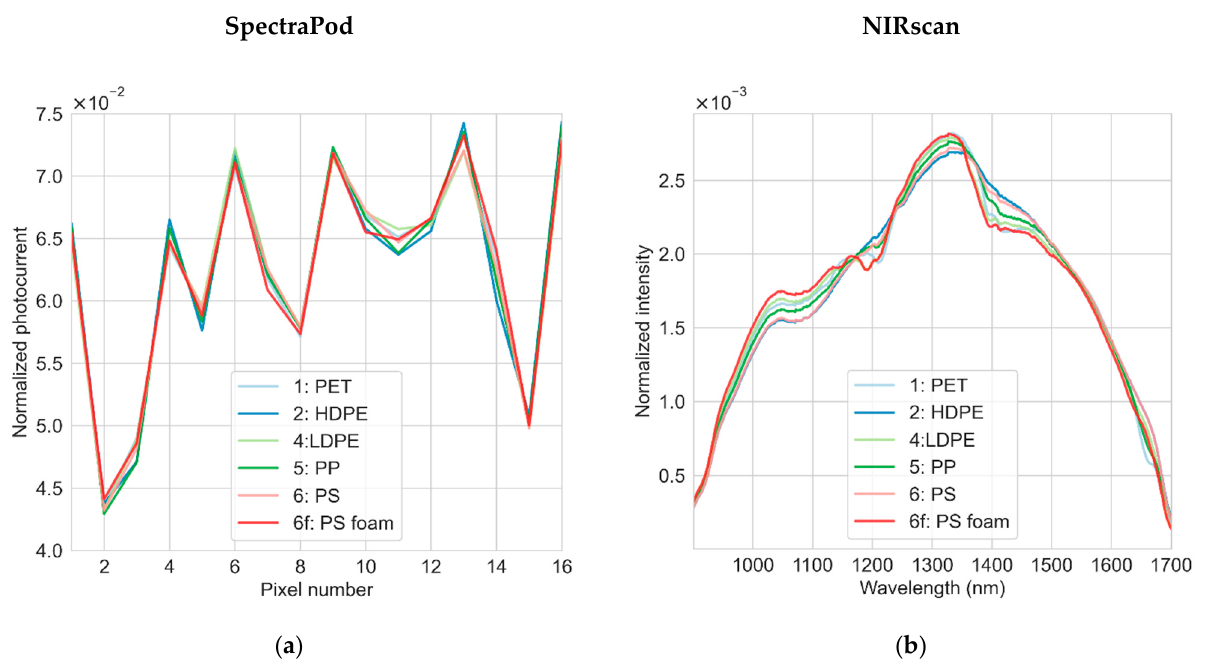
Figure 4. The average measurement of each plastic type measured by the SpectraPod ( a ) and NIRscan ( b ), following normalization by the sum of all spectral points within each measurement.